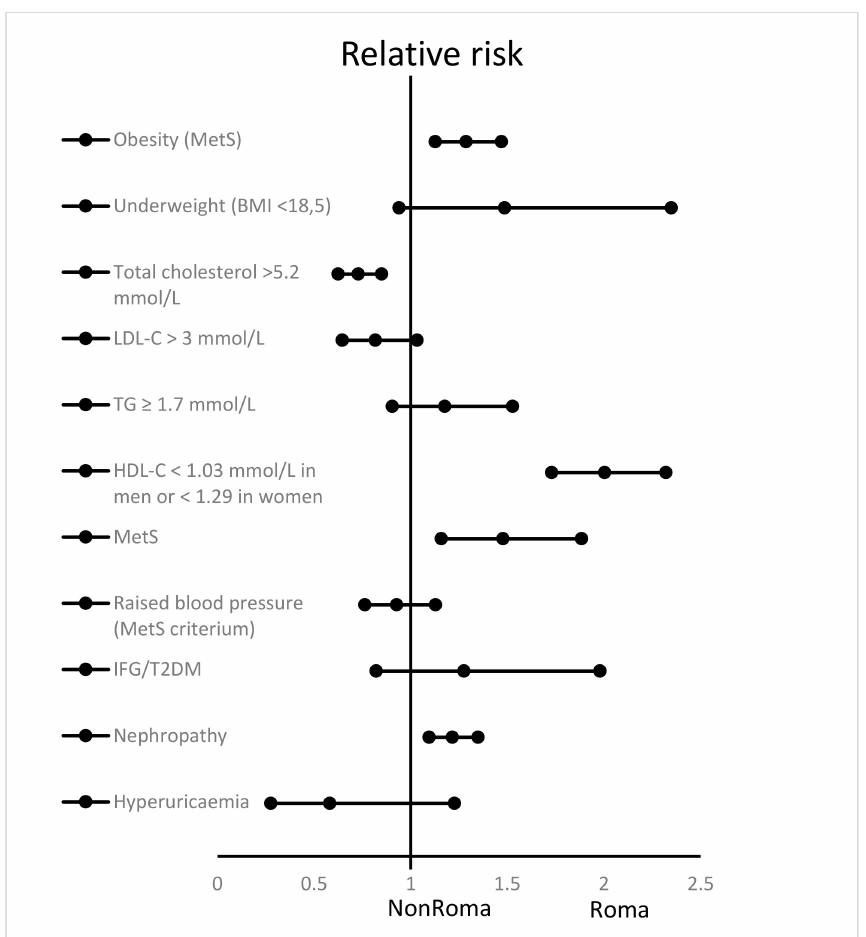
Figure 2. Relative risk with 95% confidence intervals of common non-communicable diseases and certain risk factors in Roma participants, compared with the non-Roma population. Obesity was defined as in the international diabetes foundation (IDF) 2006 MetS definition. LDL-C—low-density lipoprotein cholesterol; TG—triglycerides; HDL-C—high-density lipoprotein cholesterol; MetS—metabolic syndrome; IFG—impaired fasting glucose; T2DM—type 2 diabetes